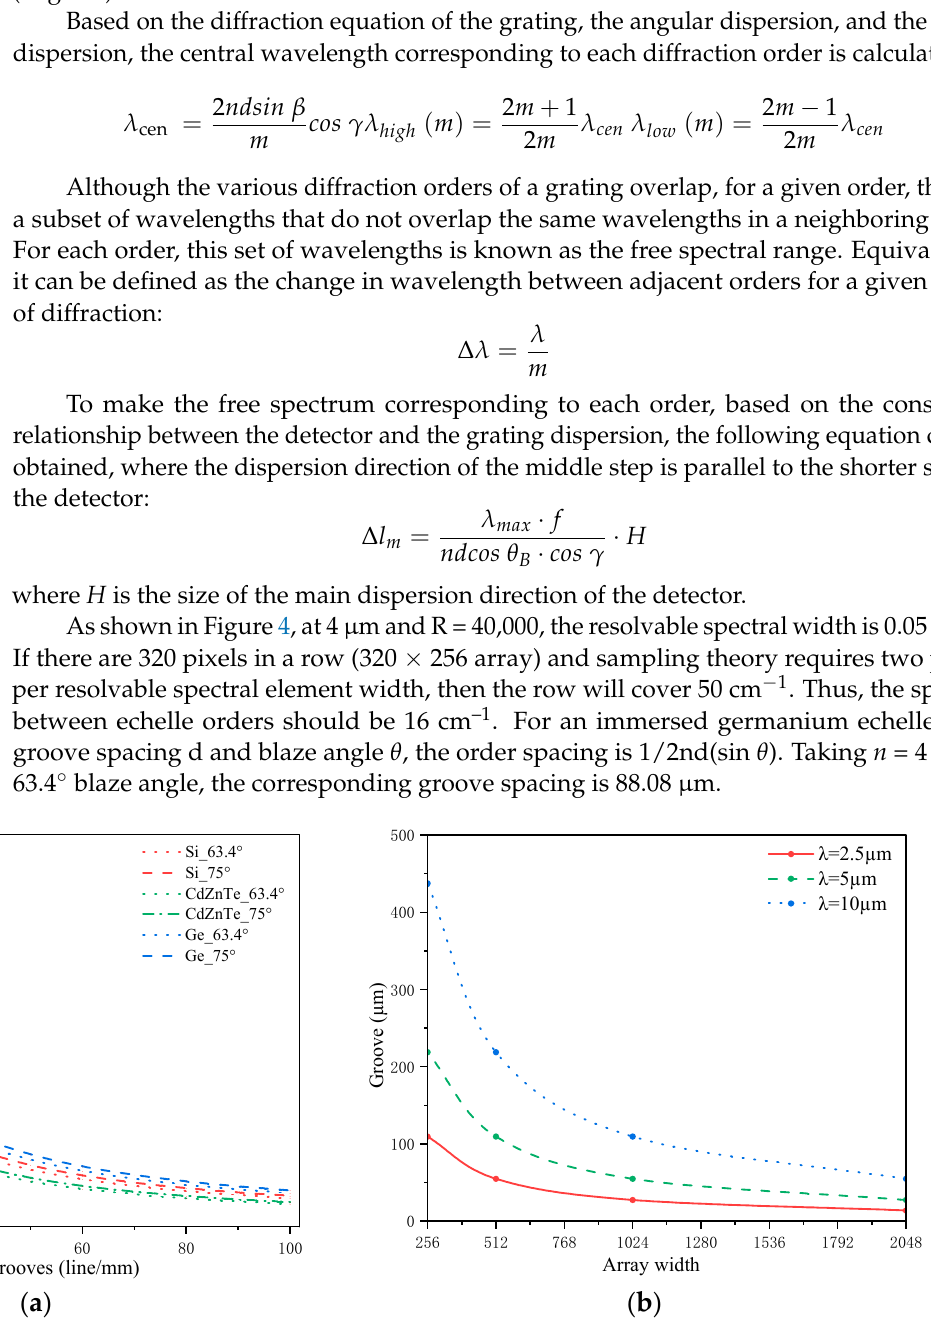
Figure 4. The relationship between grating line density and diffraction order in ( a ); Plot showing the relationship between the grating angular dispersion rate and order, with the blaze angle shown in the upper panel and groove spacing as a function of wavelength and pixel format in ( b ).